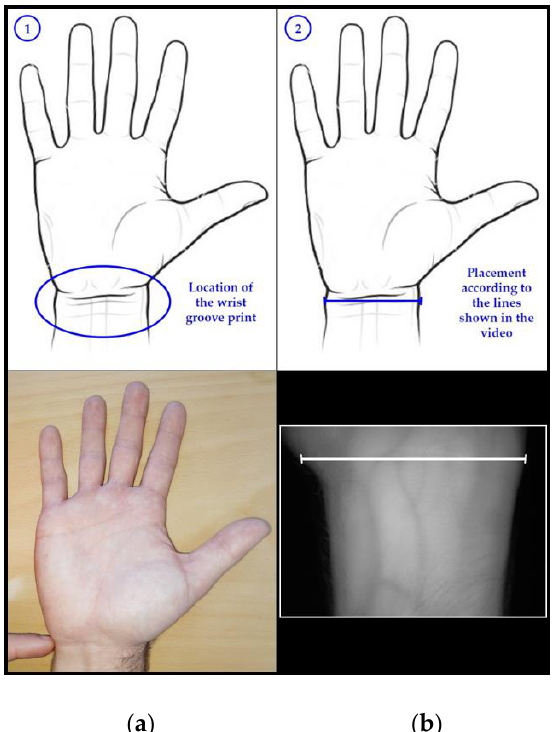
Figure 2. Three-Guideline Software for Contactless Vascular Biometric Recognition (TGS-CVBR ® ), wrist positioning steps (based on [1]). ( a ) Step 1: the location of the wrist groove line. ( b ) Step 2: match of the wrist groove print and the guideline.